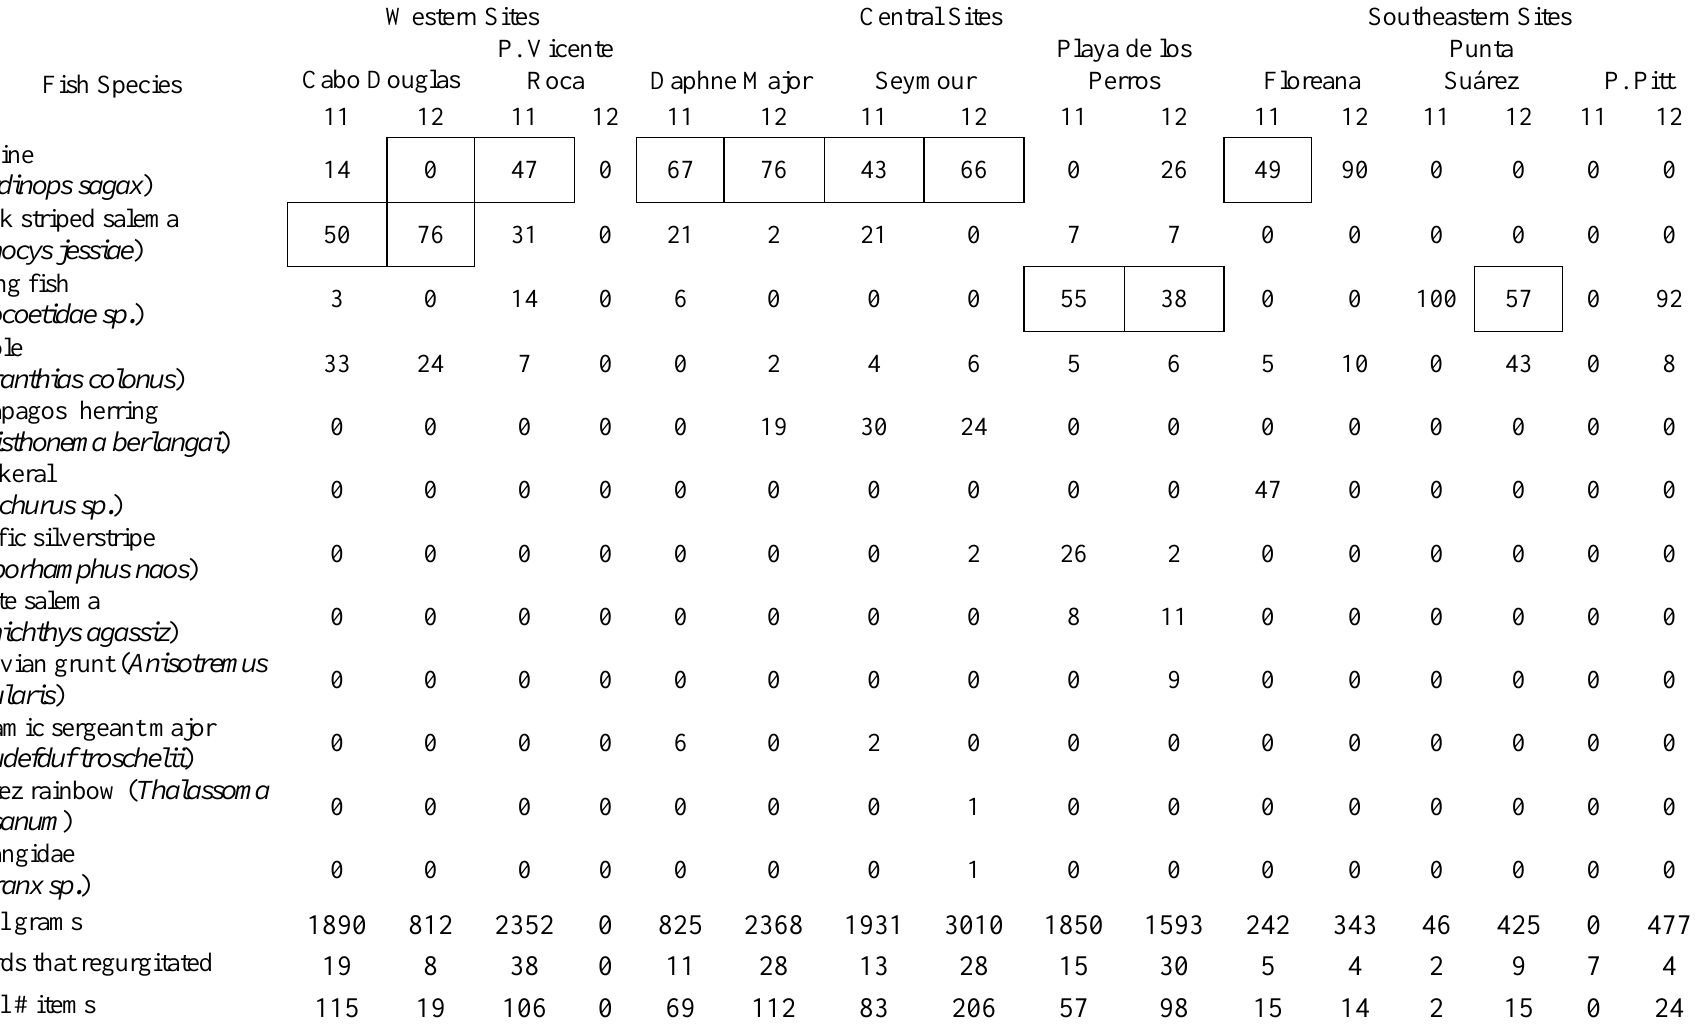
Table A1.2. Representation of prey items by weight in regurgitation samples. Numbers represent percentage of grams and sum to 100 vertically. The most important prey species for each column is identified with a box. For each colony, “11” = 2011 and “12” = 2012. “Total grams” is the total grams of fish collected during that year at that